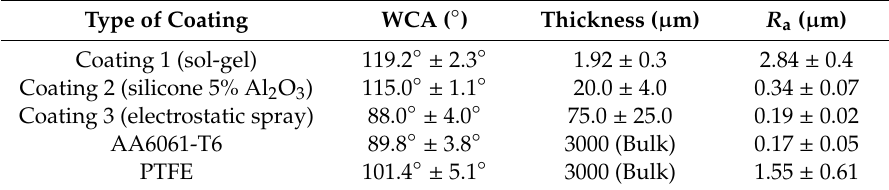
Table 1. WCA, thickness and roughness of the as-fabricated coatings.